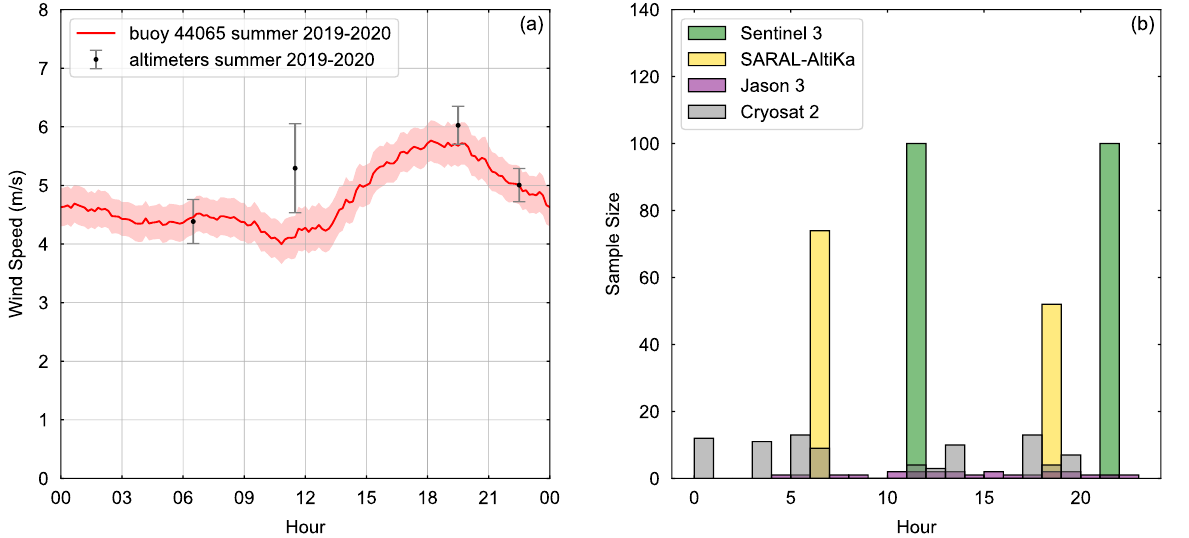
Figure 11. A visualization of the diurnal bias due to the altimeter sampling frequency compared with the buoy 44065 data for the summer season. ( a ) shows the WS diurnal cycle (red line) for buoy 44065 during the summer, the shaded red area represents its 95% confidence interval along with the estimated average altimeter WS and its estimated errors, at a one-degree radius around the buoy location. The X axis in ( b ) represents each altimeter’s sample size at each hour (Y axis) during the